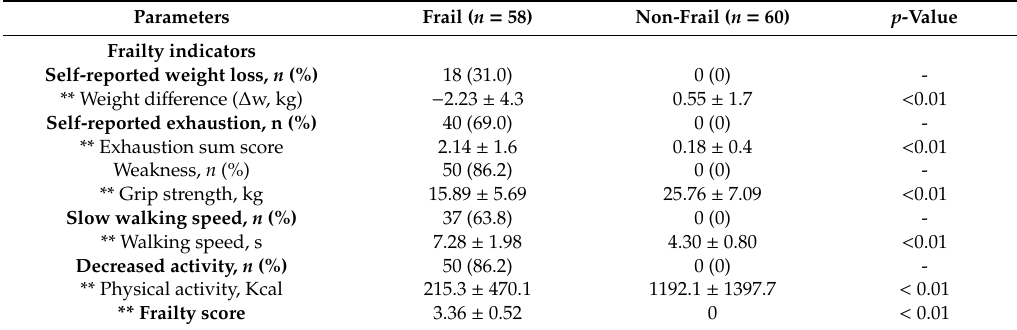
Table 3. Comparisons of frailty indicators between the frail and the non-frail phenotype.